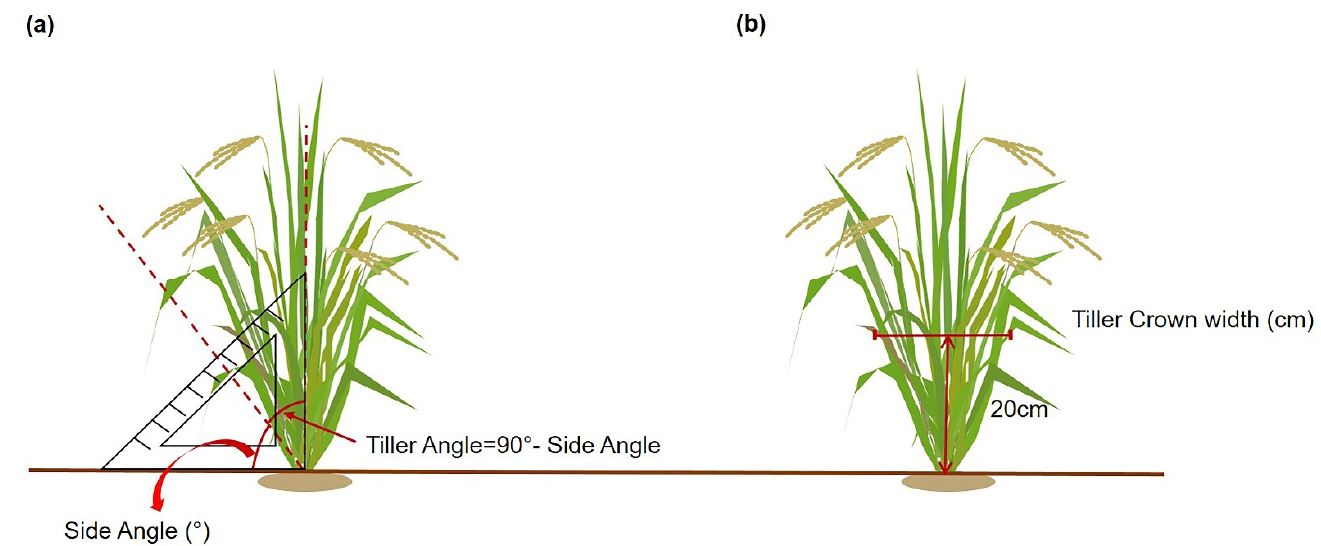
Figure 1. Method for measuring tiller angle and tiller crown width. ( a ) The side angle has measured the angle from the ground to the outermost tillers using a protractor. The tiller angle was calculated by subtracting the side angle from the 90° angle. ( b ) Method for measuring the tiller crown width. The width of the crown was determined by measuring the width of the tiller per plant at 20 cm above the soil surface.